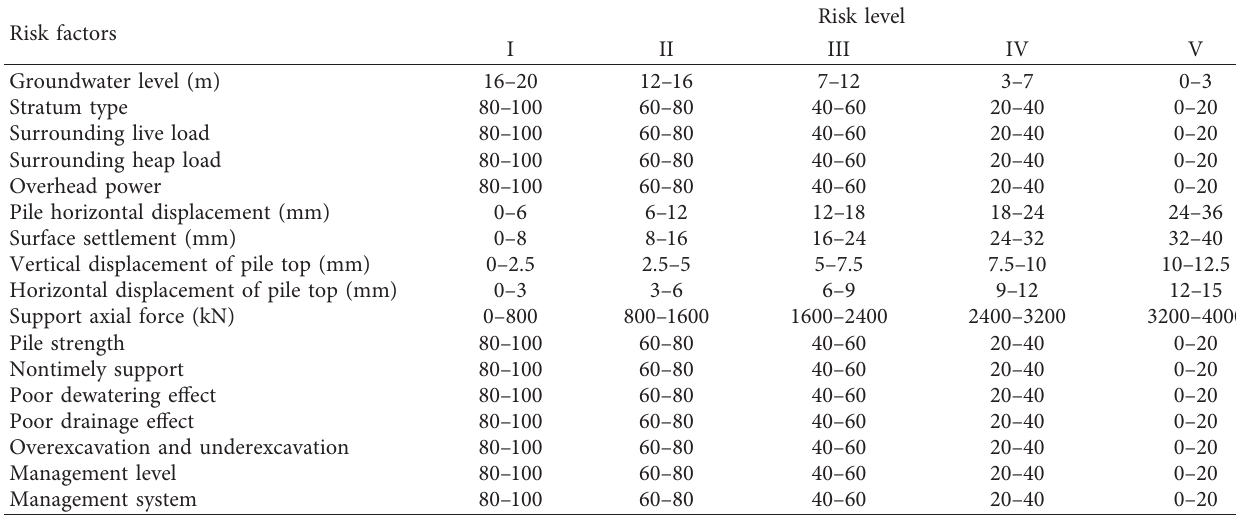
Table 5: Risk level.